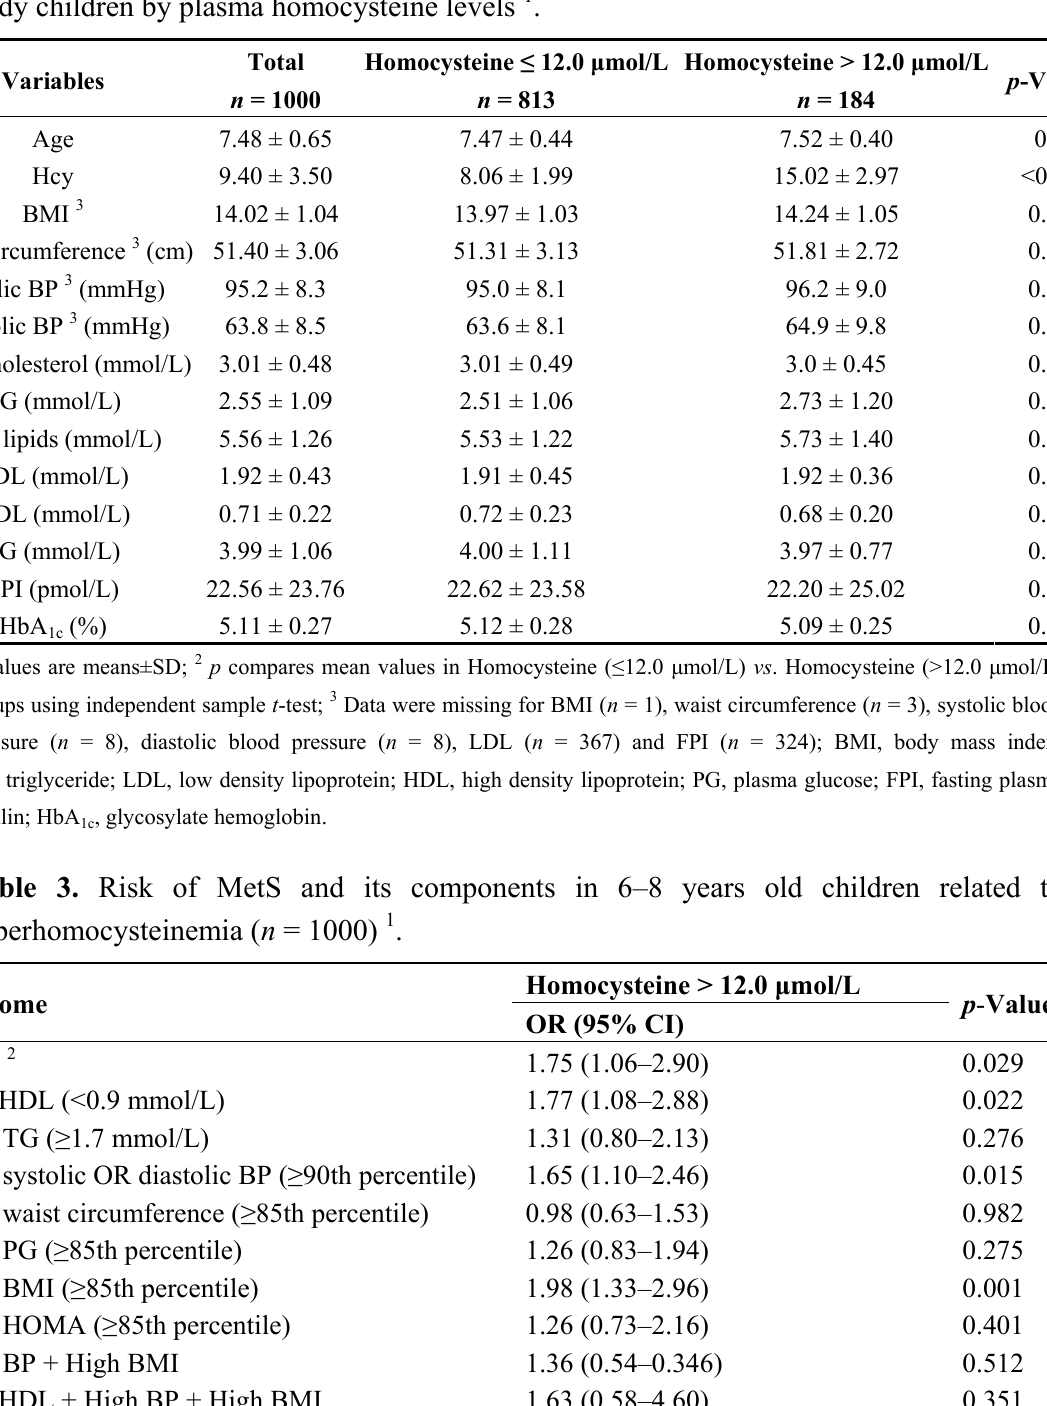
Table 2. Anthropometric measures, blood pressure, and plasma biochemical biomarkers of study children by plasma homocysteine levels 1 .